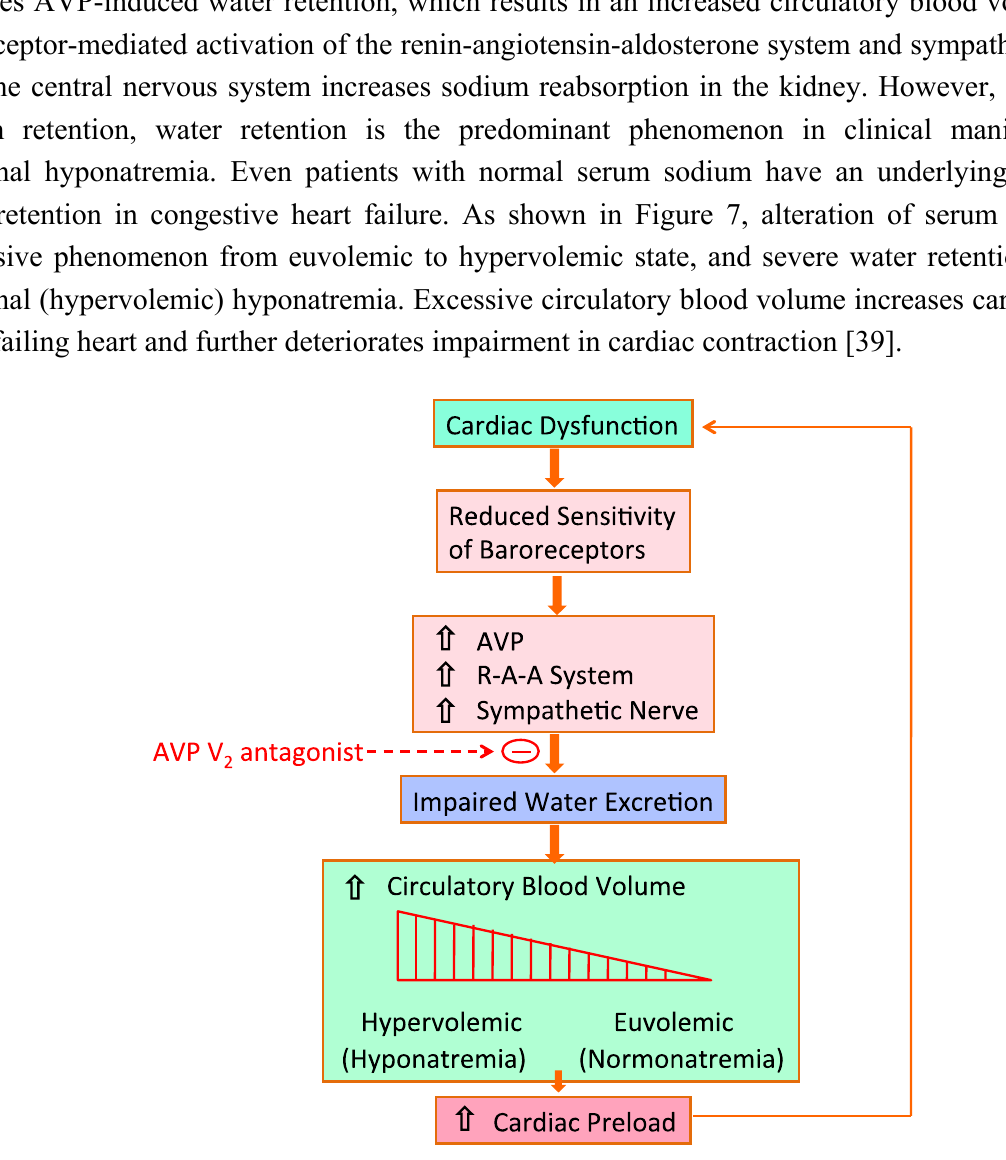
Figure 7. Baroreceptor-mediated hormone-dependent water retention in heart failure. Cited from